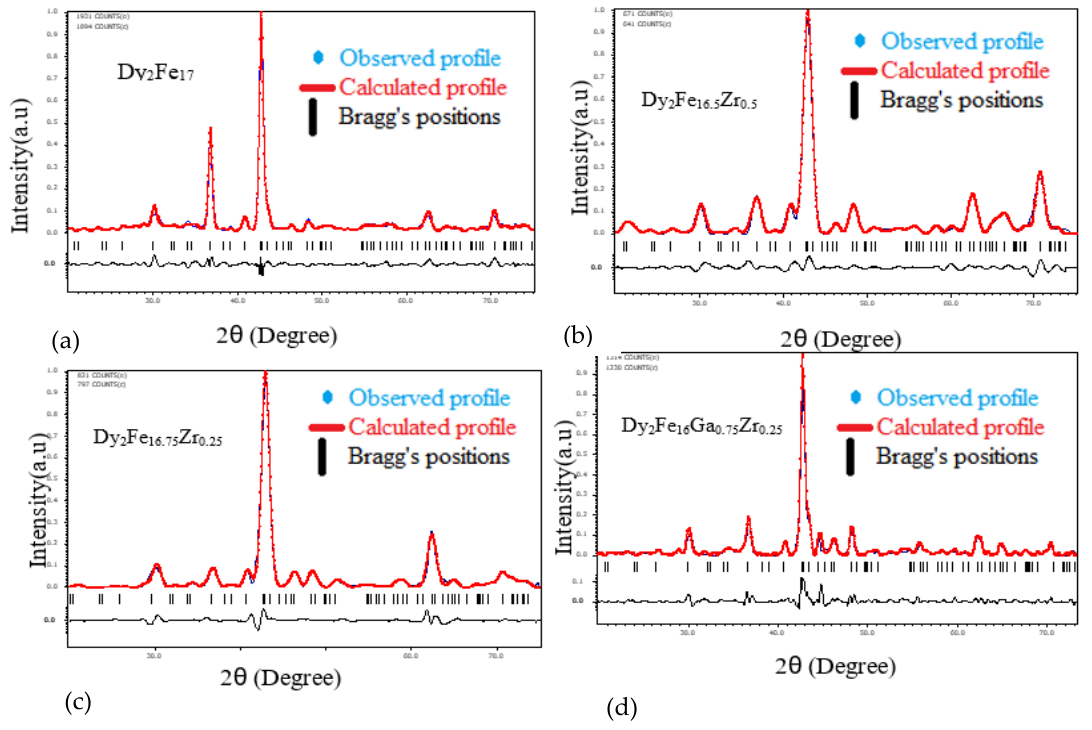
Figure 1. Rietveld refinement profile for ( a ) Dy 2 Fe 17 , ( b ) Dy 2 Fe 16.5 Zr 0.5 , ( c ) Dy 2 Fe 16.25 Zr 0.75 and ( d ) Dy 2 Fe 16 Ga 0. Zr 0.25 . Table 1. Lattice parameters and unit cell volume of Dy 2 Fe 17 − x Zr x and Dy 2 Fe 16 Ga 1 − x Zr x obtained from Rietveld